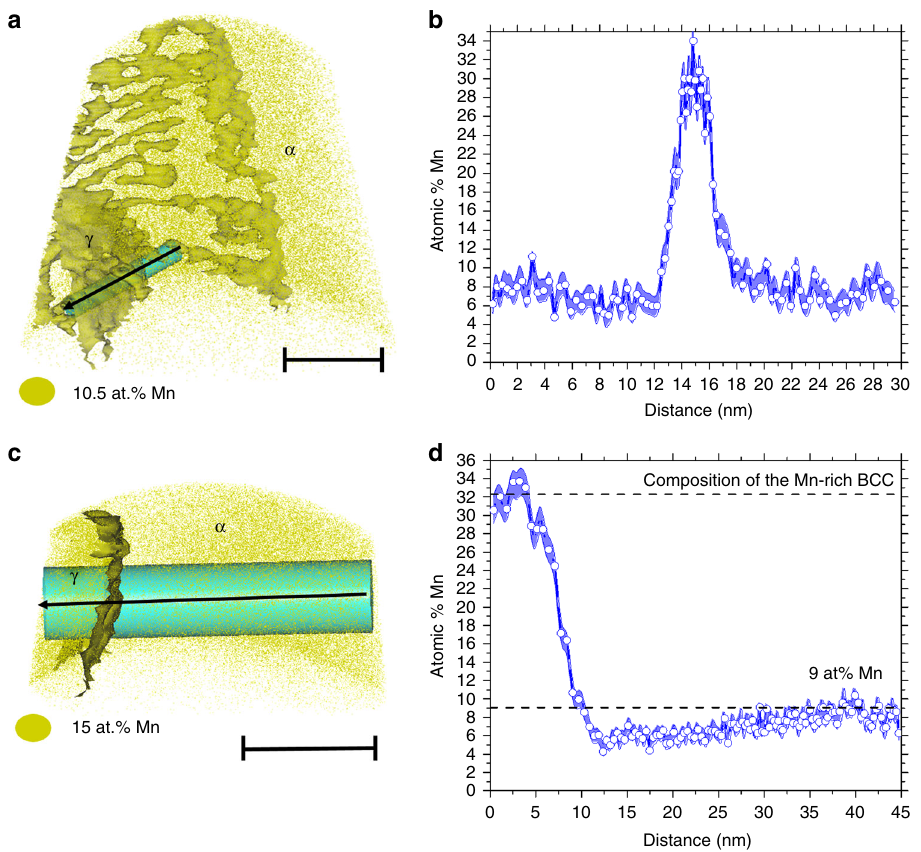
Fig. 7 Composition of the austenite after 6 h and 2 weeks at 450 °C. a , b Fe-9 atomic % Mn solid solution, 50% cold-rolled, and annealed at 450 °C for 6 h: a APT reconstruction showing an austenite nucleus sited on an LAGB or a triple junction of LAGB. b 1D compositional pro fi le along the cylinder showed in a . c , d Fe-9 atomic % Mn solid solution, 50% cold-rolled, and annealed at 450 °C for 2 weeks: c APT reconstruction showing an austenite nucleus in initial stage of growth. d 1D compositional pro fi le along the cylinder showed in c . α represents the BCC-ferrite phase and γ represents the FCC-austenite phase. The points in b , d are the experimental values, which are connected by blue lines. The blue shading represents the statistical error associated with